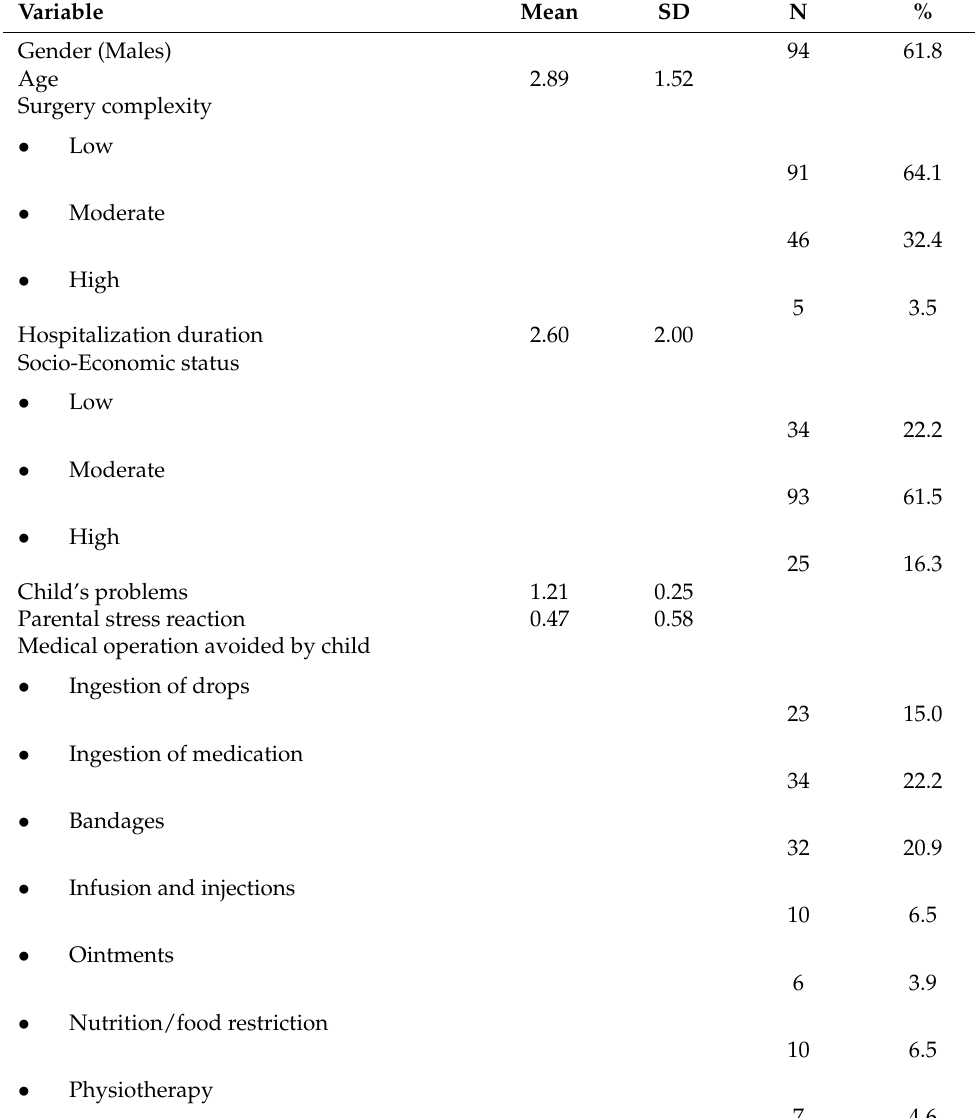
Table 1. Demographic and clinical background characteristics of the